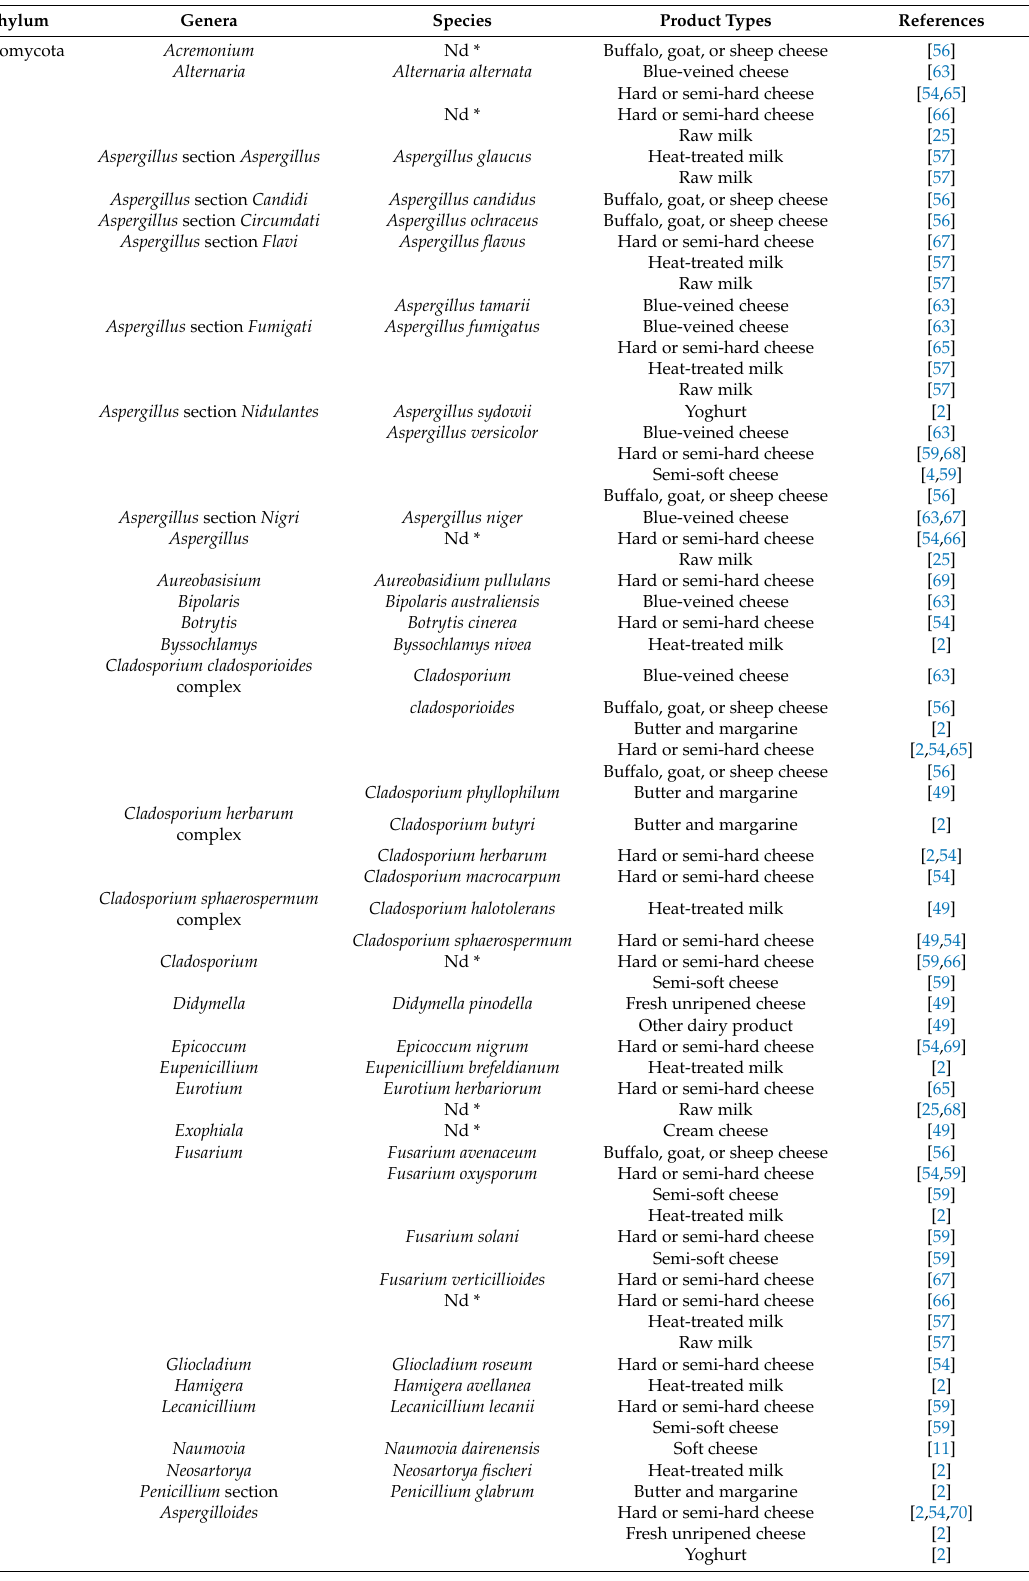
Table 2. Diversity of spoilage filamentous fungi isolated from contaminated dairy products.